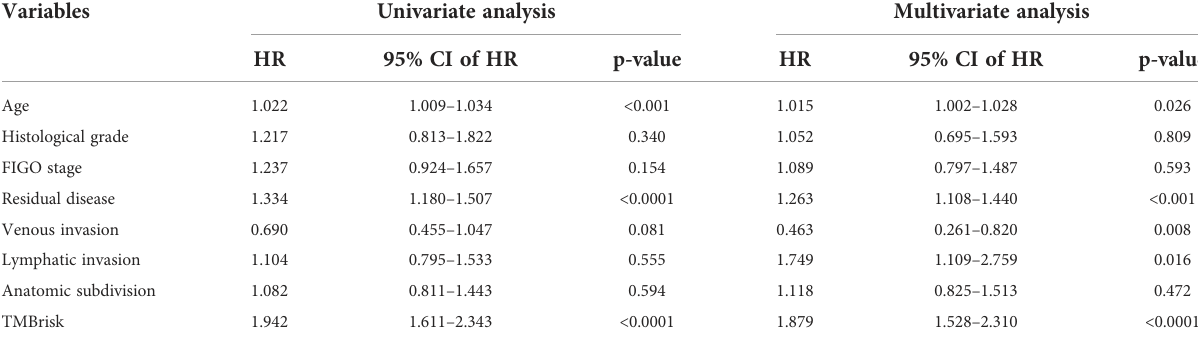
TABLE 1 Univariate and multivariate Cox regression analyses of clinical features and TMBrisk with OS in TCGA.